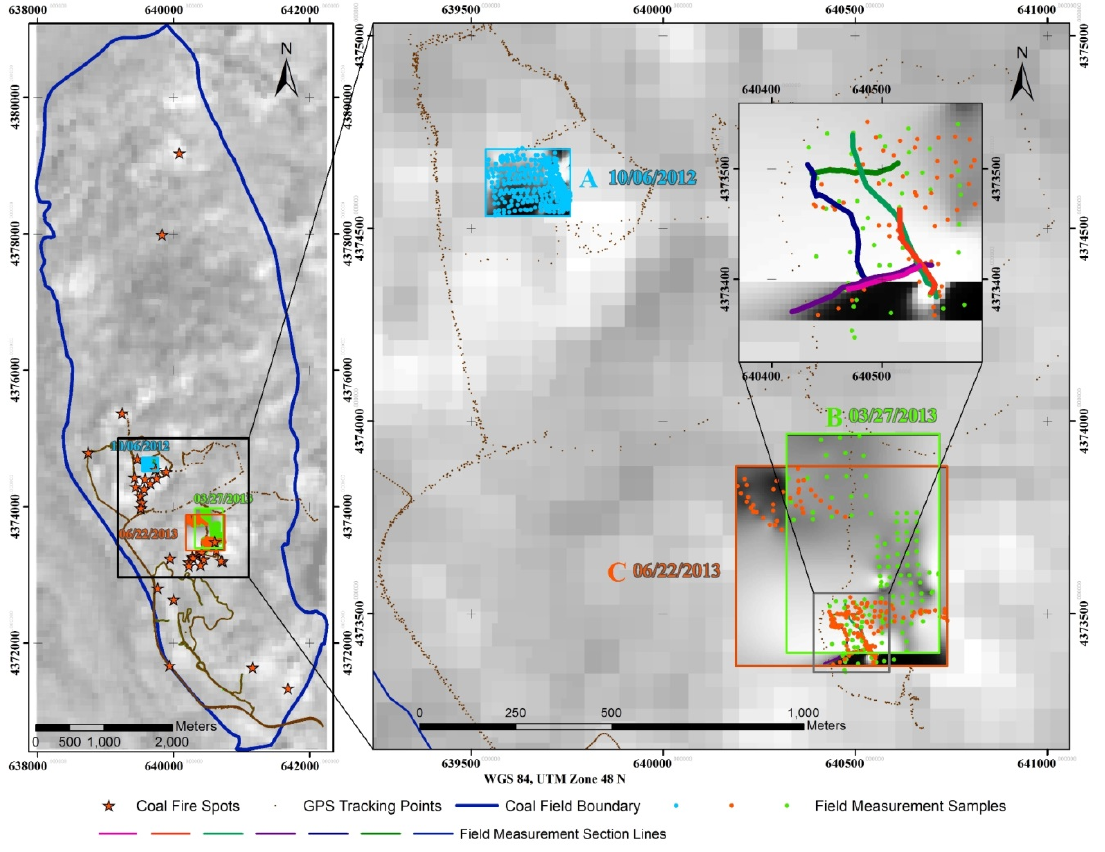
Figure 5. Field measurement strategies including three blocks and six sampling lines. Field surveys were conducted on 6 October 2012 (block A, blue dots), 27 March 2013 (block B, green dots), and 22 June 2013 (block C, orange dots). Blocks A, B and C included burning areas, coal fire edges, transitional areas and